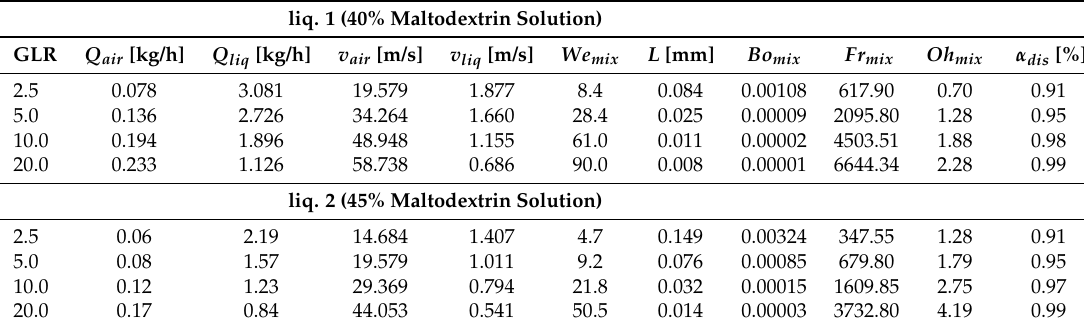
Table 3. Working parameters of the Y-jet nozle.